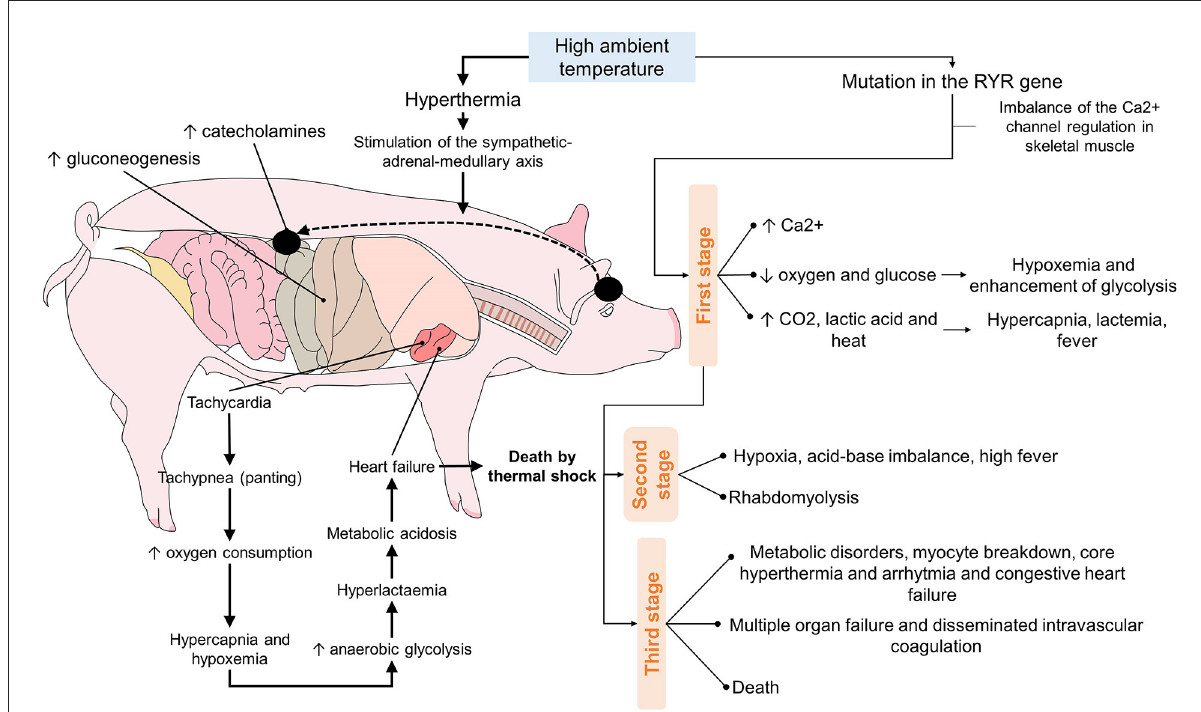
FIGURE4 Sequence of the events that culminate in the death of hogs due to the effects of high ambient temperatures.